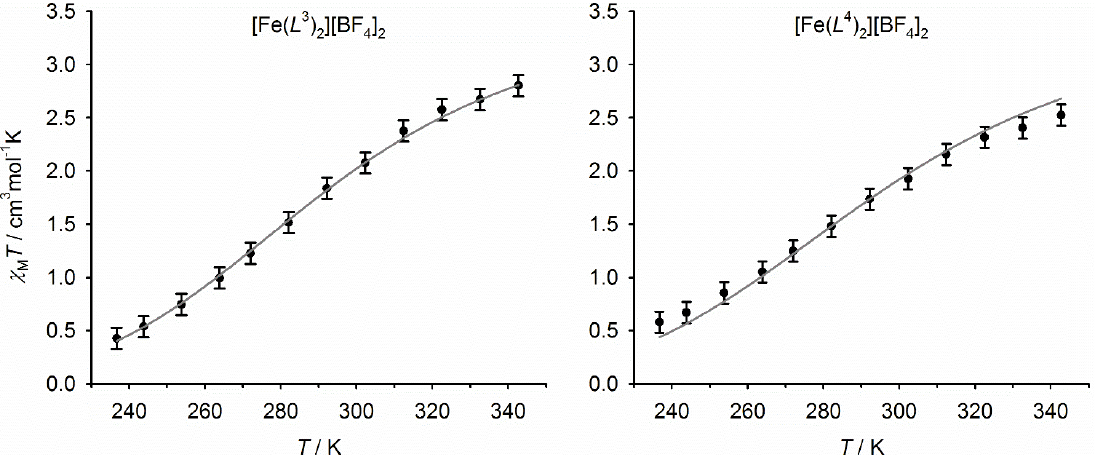
Figure 7. Magnetic susceptibility data for [Fe( L 3 ) 2 ][BF 4 ] 2 (left) and [Fe( L 4 ) 2 ][BF 4 ] 2 (right) in CD 3 CN solution. The lines show the fits of the data to Equations (1) and (2).